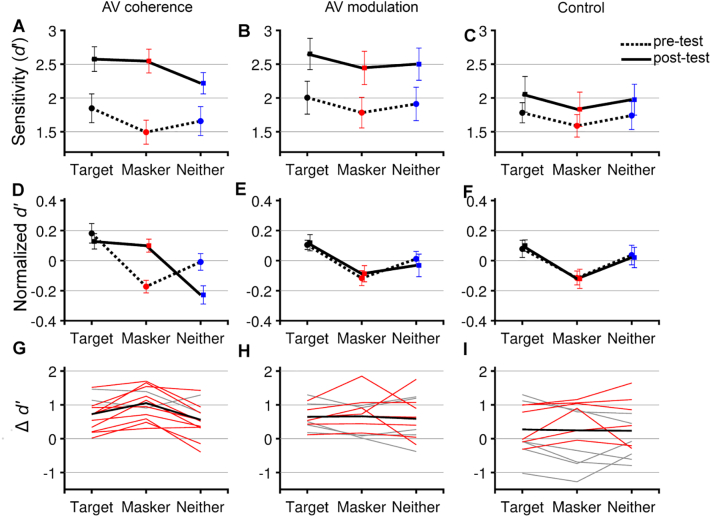
Training to detect AV temporal coherence changed how listeners utilized visual information. A-C pretest (dashed line) and post-test (solid line) performance in the auditory selective attention task according to AV coherence conditions. A, D, G: AV coherence training group, B, E, H: AV modulation training group, C, F, G: control group. D-F Normalized mean ± SEM performance (calculated as within condition d’ normalized to across condition performance for pretest and post-test separately). G-I the difference in d’ between pre and post-test for each participant in either gray, or red. Participants who showed a greater increase in the masker coherent condition than the target coherent after training are plotted in red, the group mean is plotted in bold black.